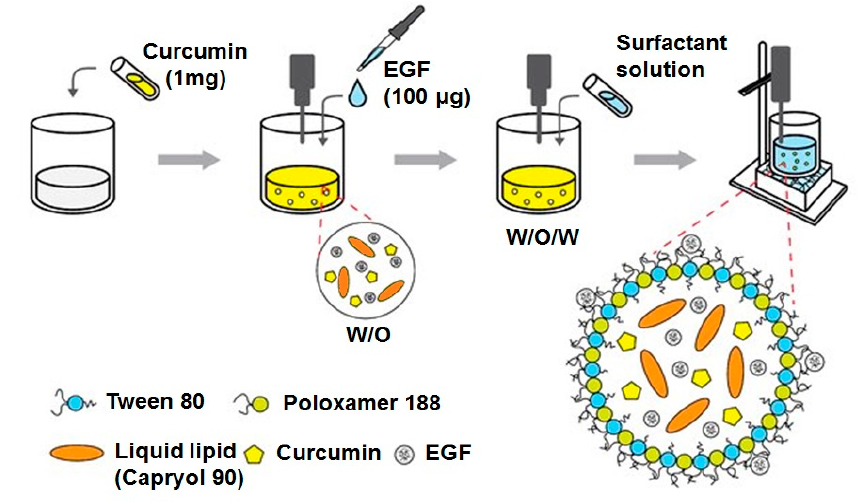
Figure 8. Preparation process of EGF–Cur-NLC.